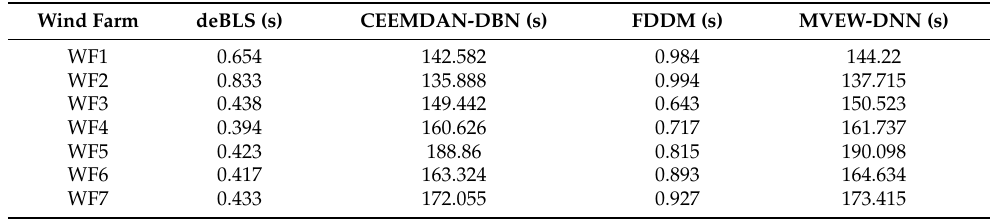
Table 6. The time computation costs of deBLS, CEEMDAN-DBN, FDDM, and the proposed MVEW-DNN. Wind